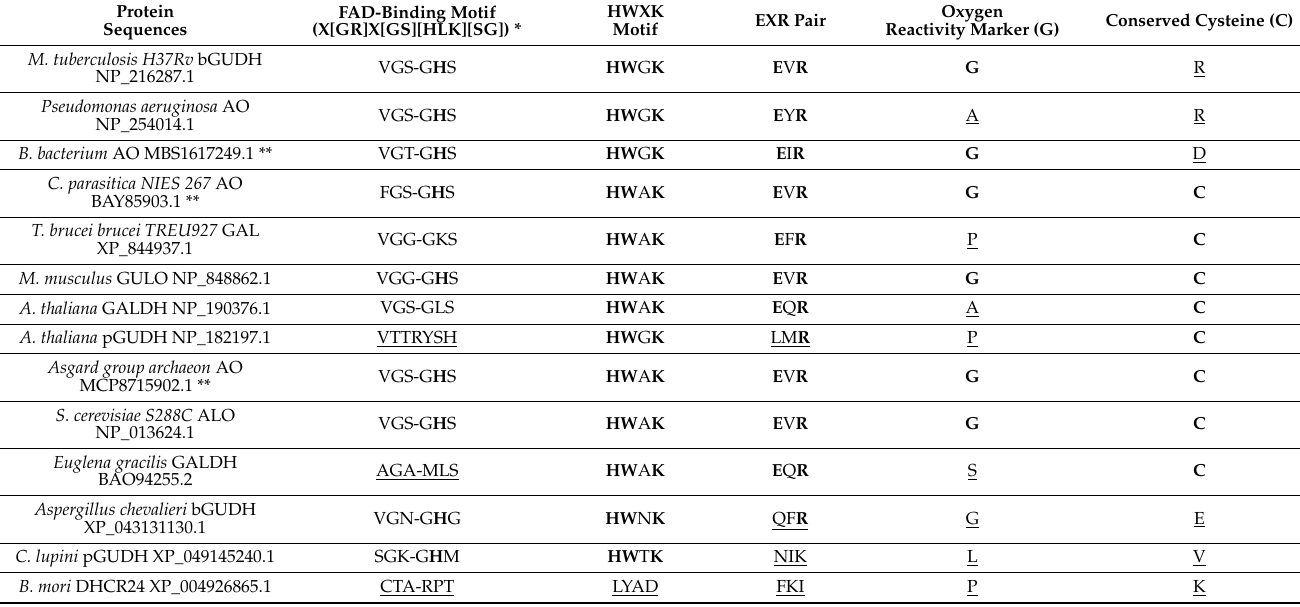
Table 1. Amino acid regions relevant for AO functions in prokaryote and eukaryote species. Protein